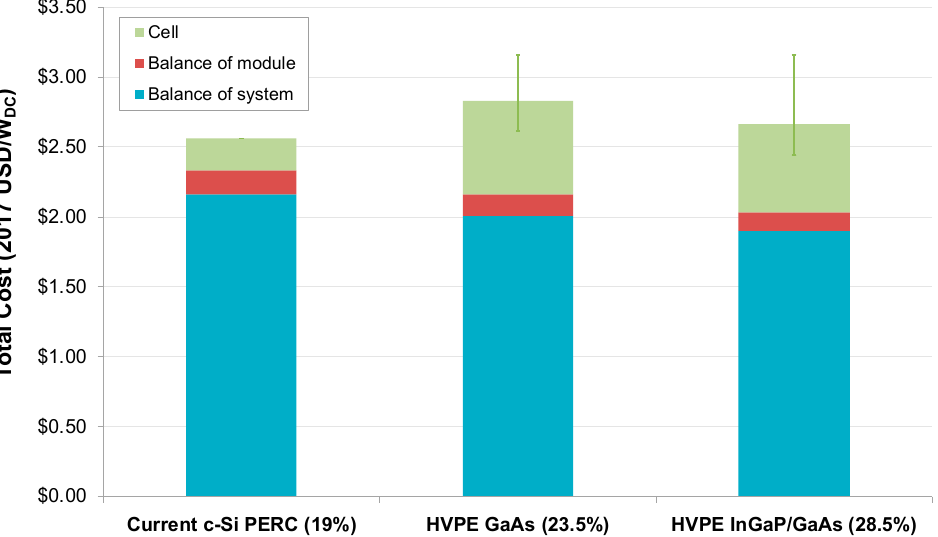
Figure 3. Comparison of total installed system costs for a 5.6 kW residential rooftop system for current monocrystalline Si PERC cells, compared to the estimates for D-HVPE-deposited GaAs and InGaP/GaAs cells, in the case where substrate costs are addressed. Assumes Chinese manufacturing and high-volume production (500 MW/year) for all cases. Cell, module, and system costs shown, include overhead costs and sustainable product margins.